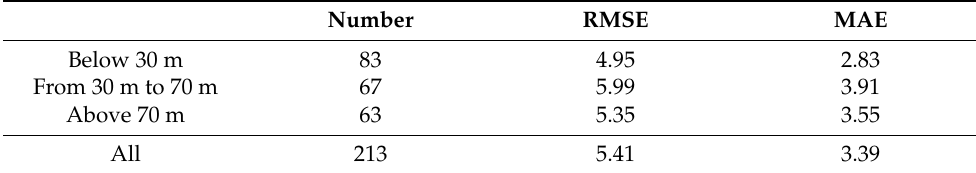
Table 3. Experimental results of GF-7 building height.